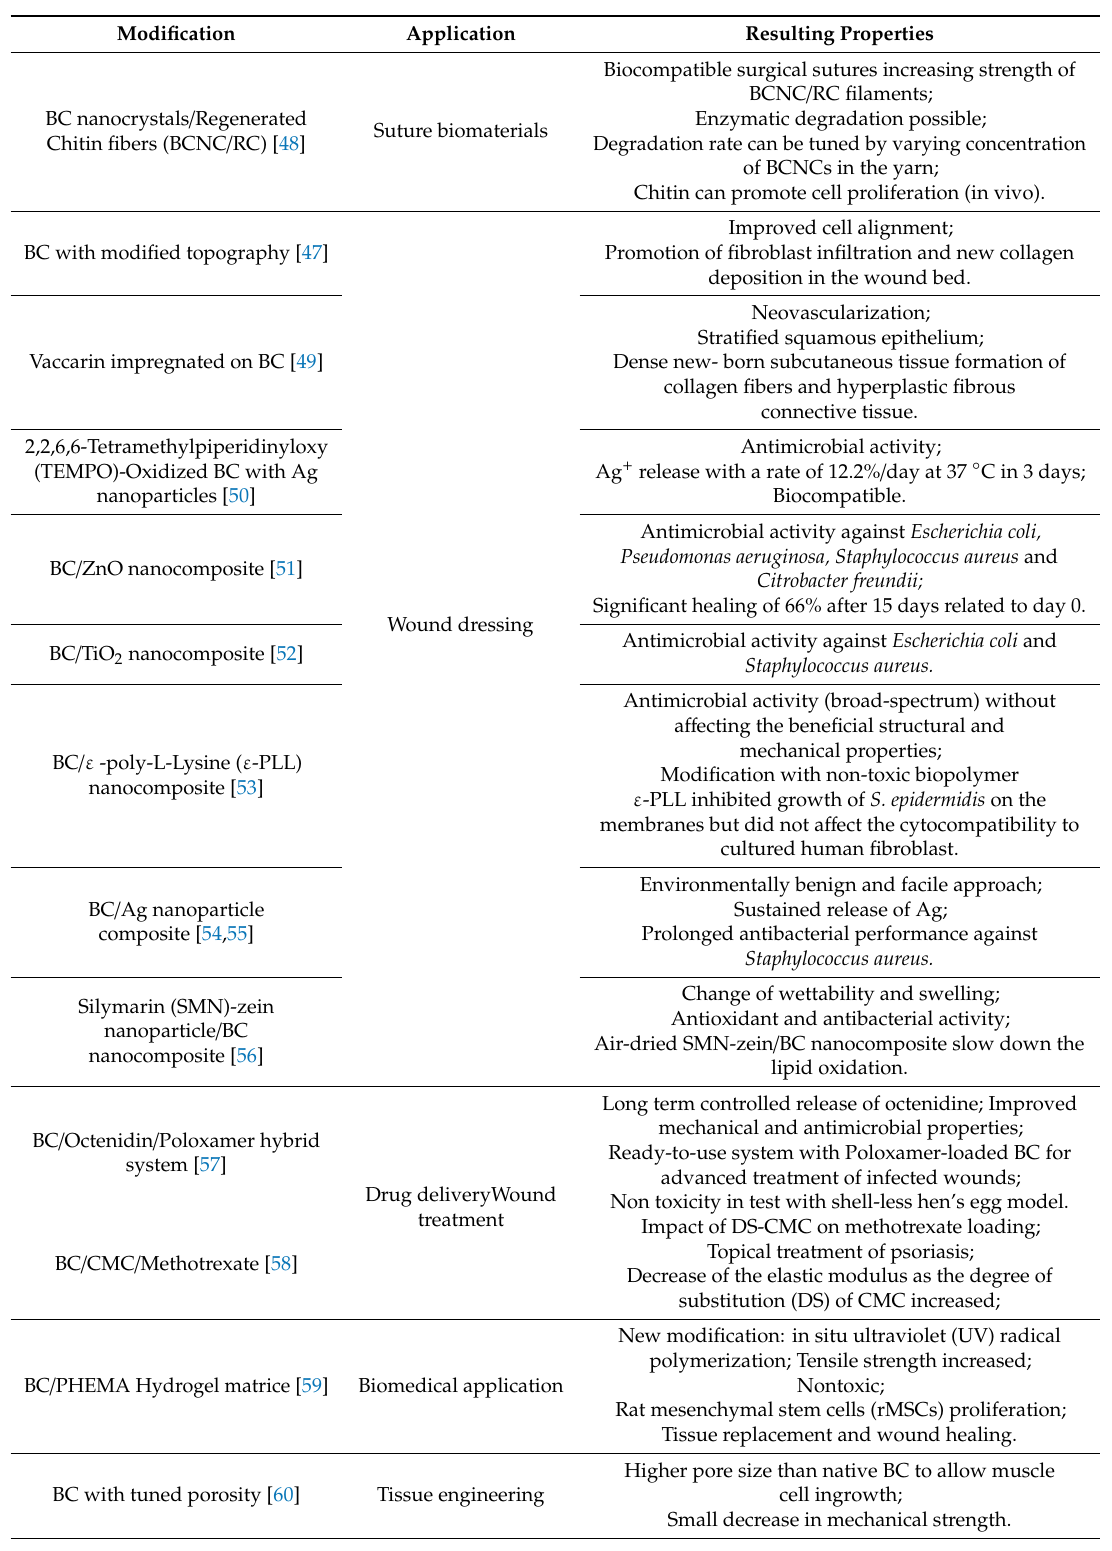
Table 2. Modifications of BC and resulting